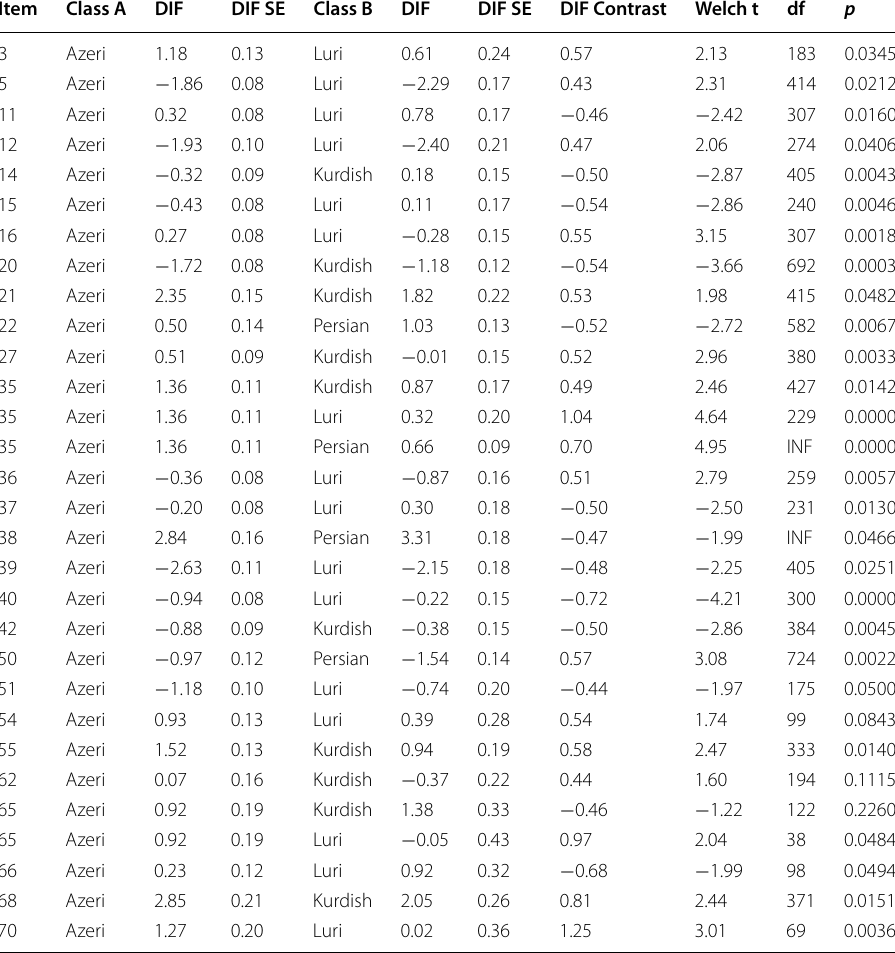
Table 12 Results of uniform DIF analysis of items (IUUESEE 2019)